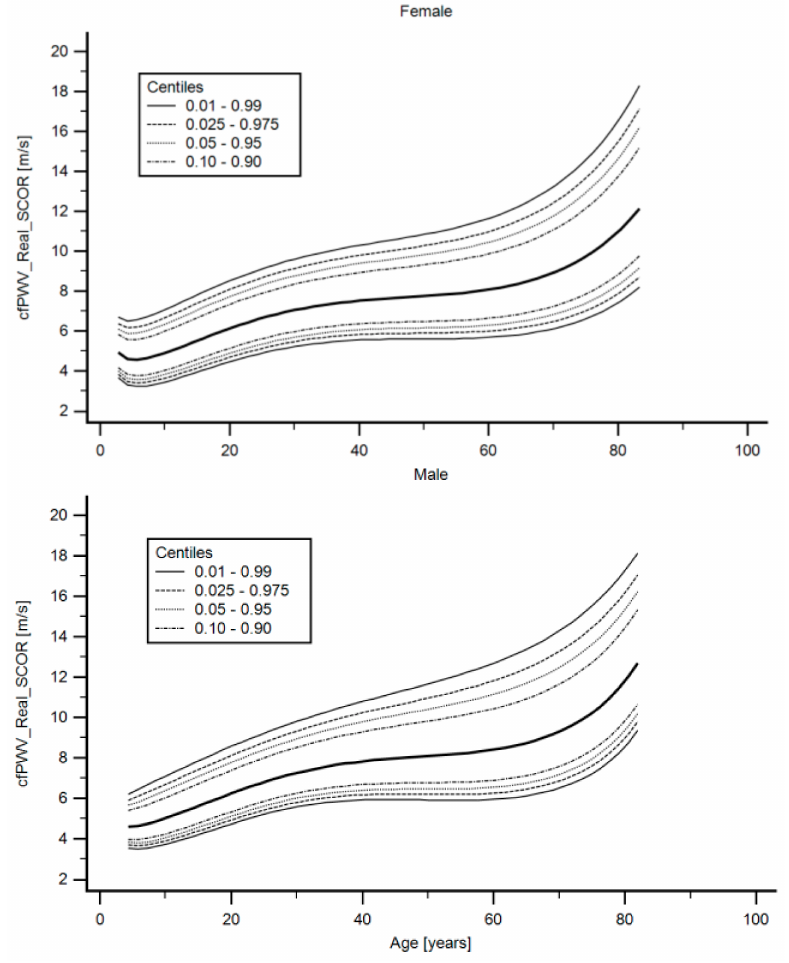
Figure 4. cfPWV_Real_SCOR age-related percentile curves for female ( top ) and males ( bottom ). Quantitative data are shown in Table 8 and Supplementary Material 1 and